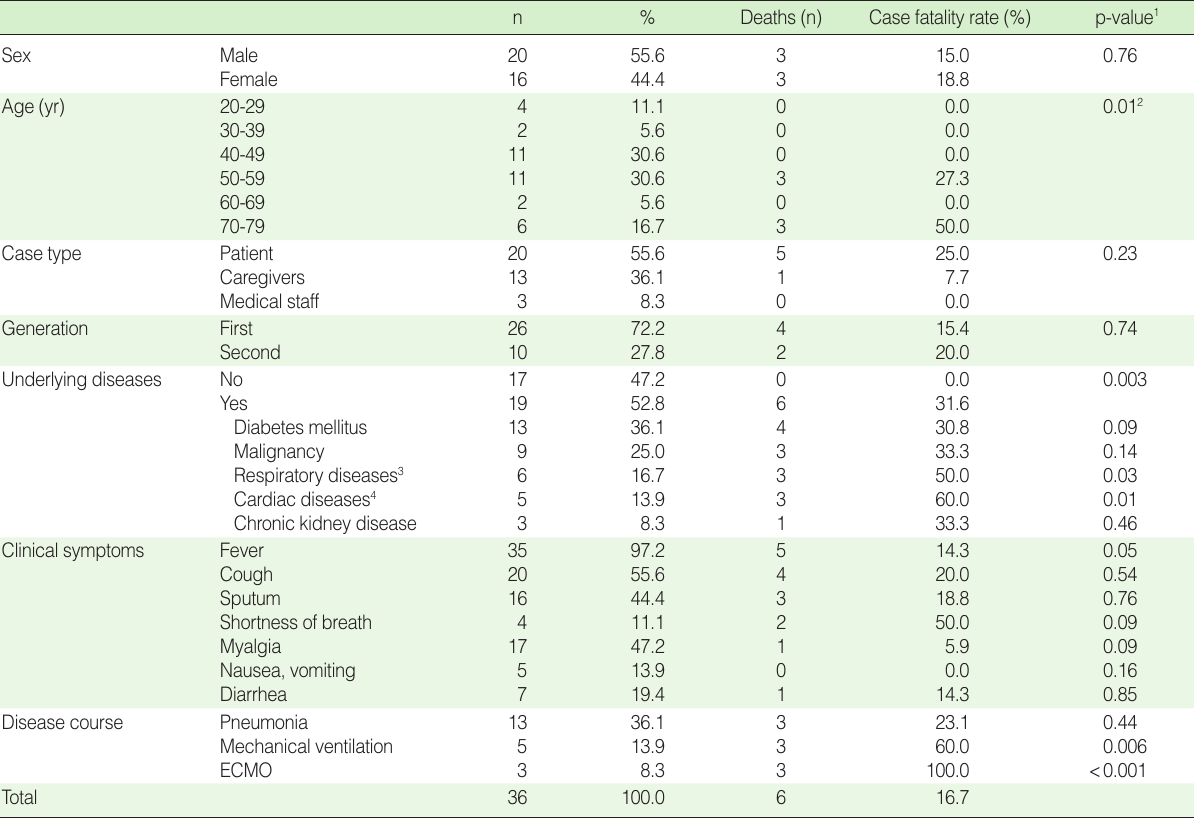
Table 2. Characteristics and fatality rates of MERS cases at Pyeongtaek St. Mary’s Hospital, Korea